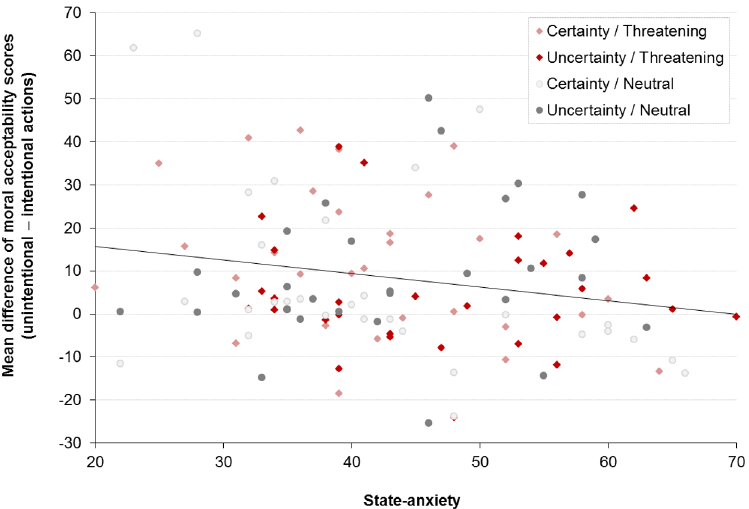
Fig 4. Relationship between state-anxiety and difference scores of moral acceptability (unintentional—intentional actions) (n = 120).